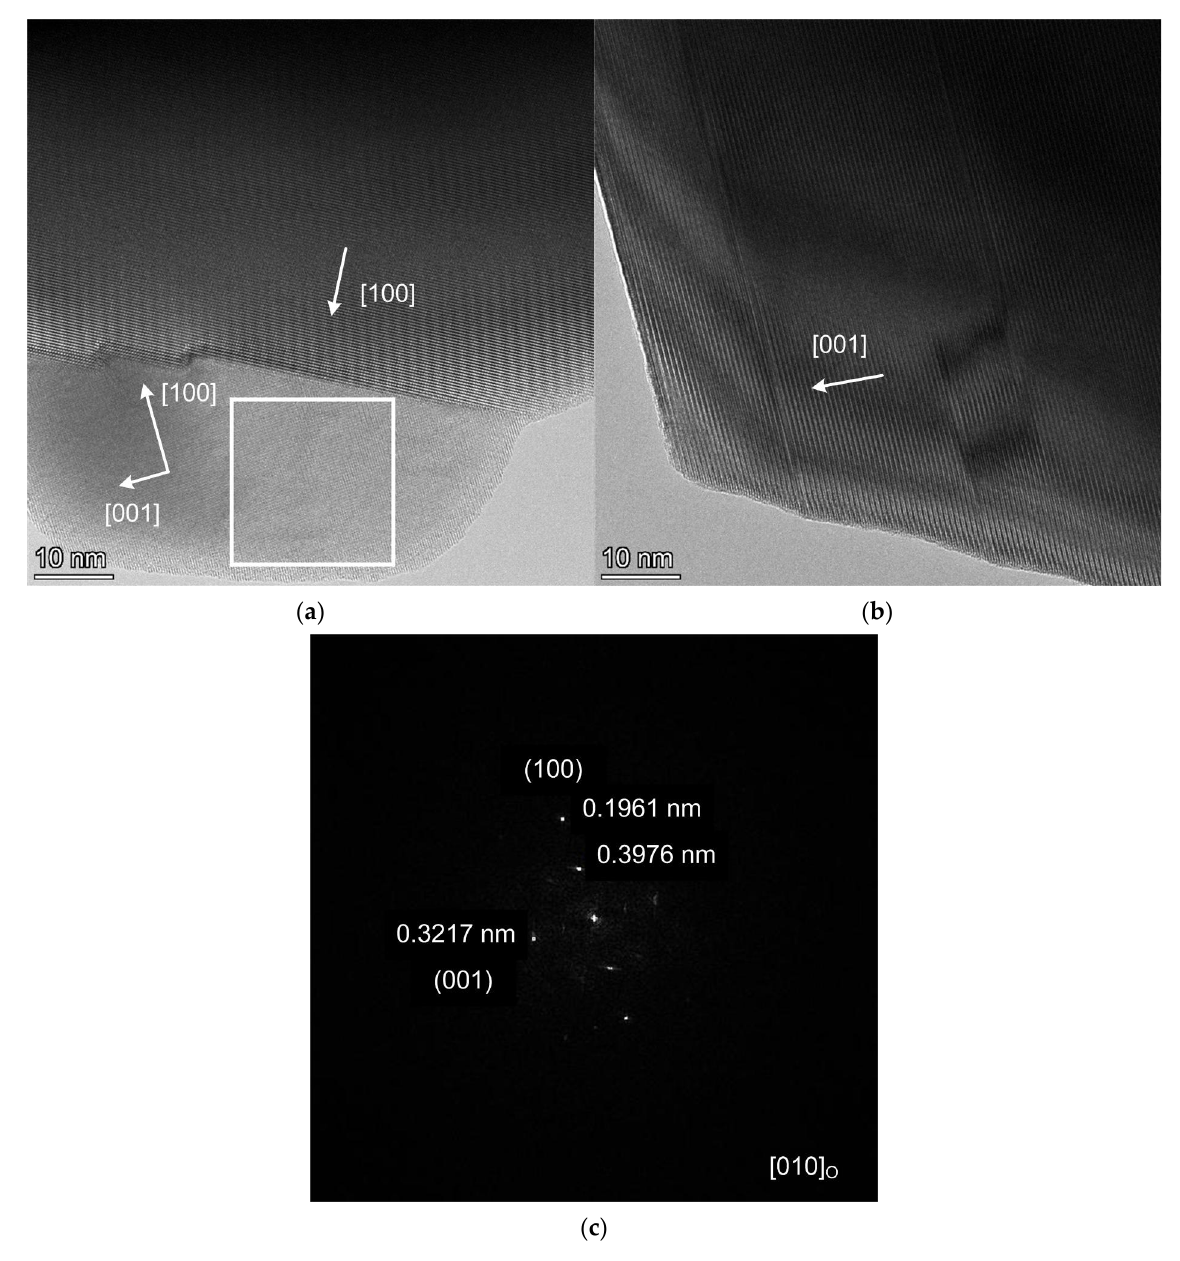
Figure 5. HRTEM image of LCNO_01_q sample—( a ); occasional stacking faults in the lattice of LCNO_01_q sample—( b ); FFT image of LCNO_01_q from ( a ) (area marked by white square, zone axis [010])—( c ).